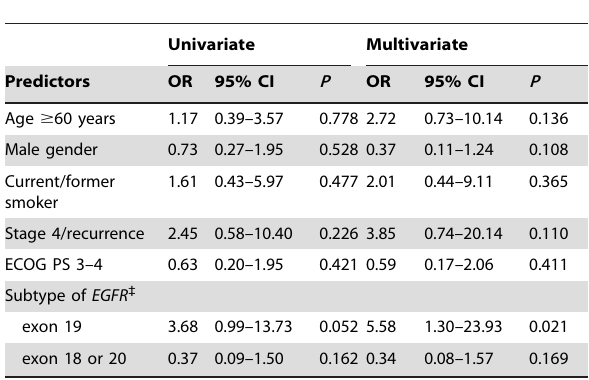
Table 4. Analysis of clinial variables associated